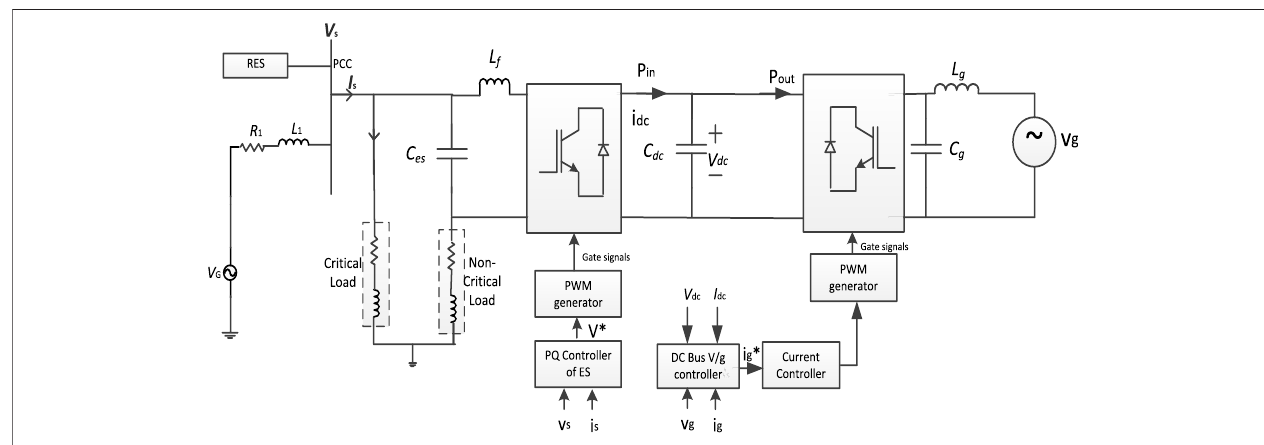
FIGURE 1 | Two-stage control circuit for bidirectional power fl ow control.